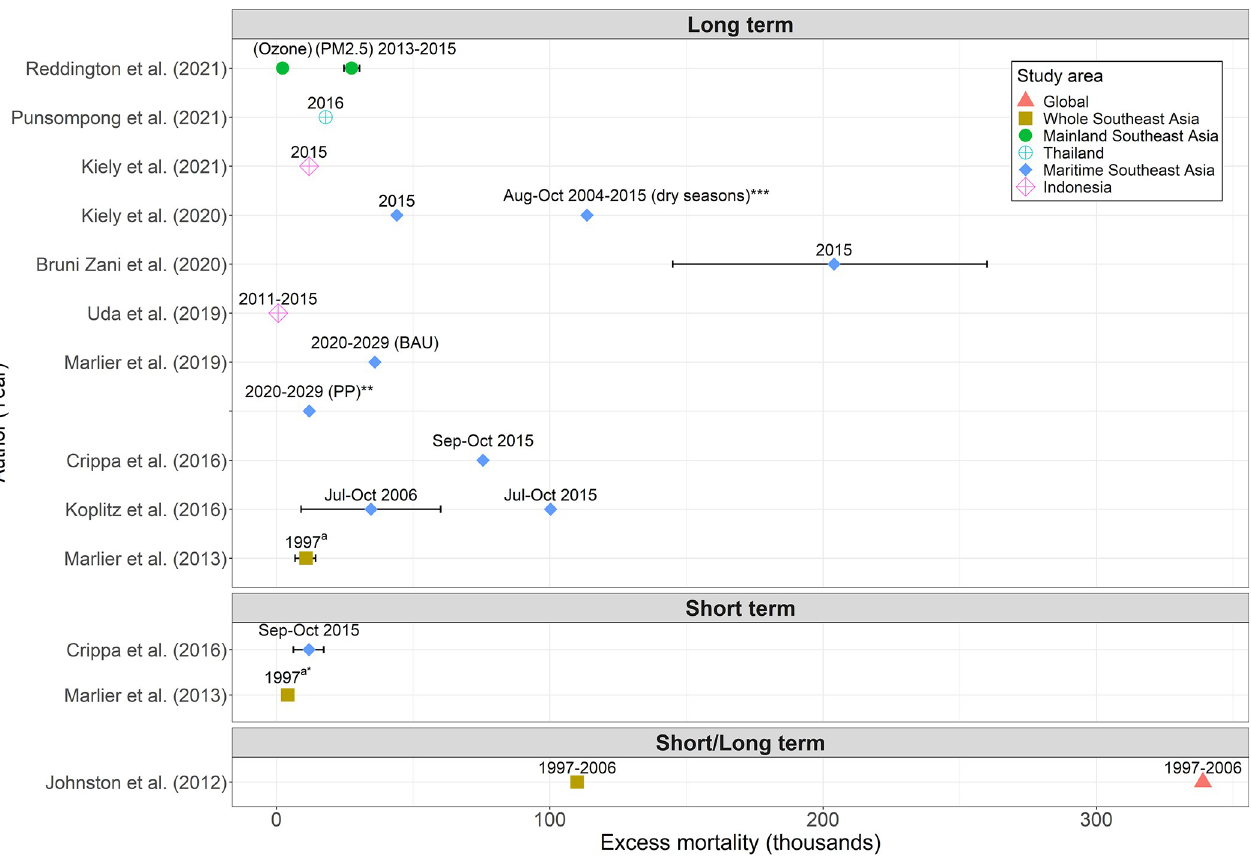
Fig 4. Excess mortality reported in health burden estimation studies in Southeast Asia using concentration-risk functions for long-term (top), short- term (middle), and both short- and long-term (bottom) exposures. a denotes cardiovascular mortality. � denotes the health burden of ozone exposure. �� denotes an averaged estimate value. ��� denotes health burden estimates from August to October of 2004, 2006, 2009, 2012, 2014, and 2015. BAU: business-as- usual scenario. PP: protecting peatland